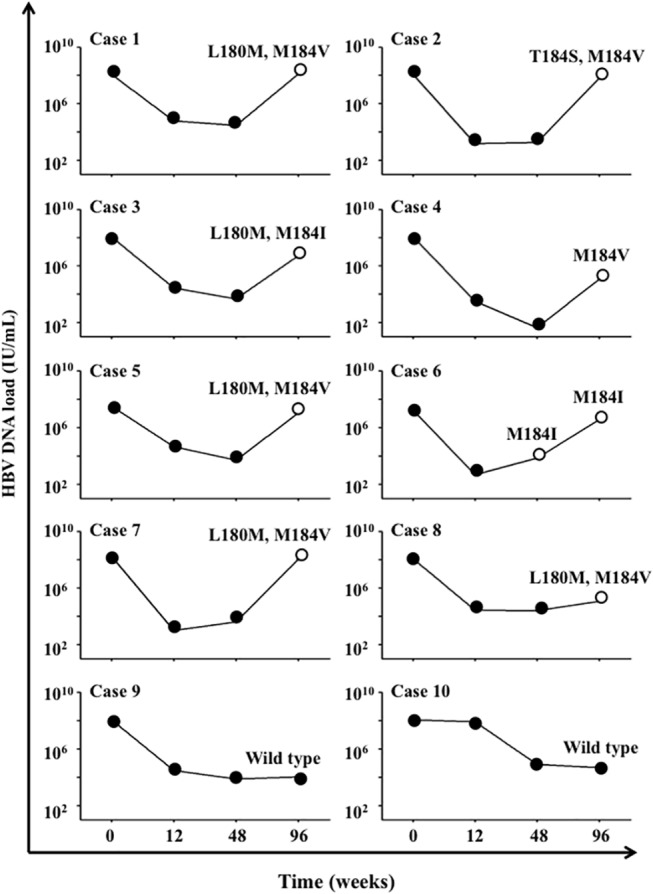
Changes in HBV DNA loads during ART in patients who exhibited insufficient suppression of HBV DNA loads.The case numbers 1–10 represent the 10 patients in whom HBV DNA loads were insufficiently suppressed. Mutations related to 3TC resistance were detected in samples collected from No.1–No.8 but not No.9 and No.10. The open circles indicate the time points at which the mutations were detected, and the mutated amino acids and their sequence numbers are listed above these circles.